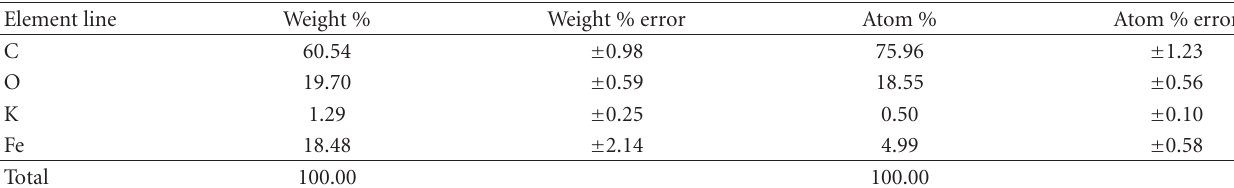
Table 4: EDS results for the Fe(III)-DHI